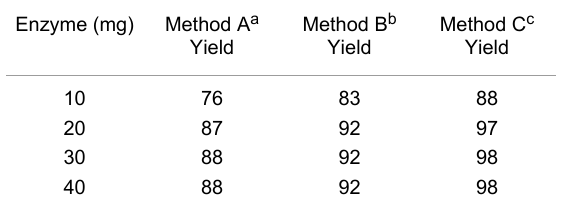
Table 5: Effect of the amount biocatalyst of using equimolar ratio at 60